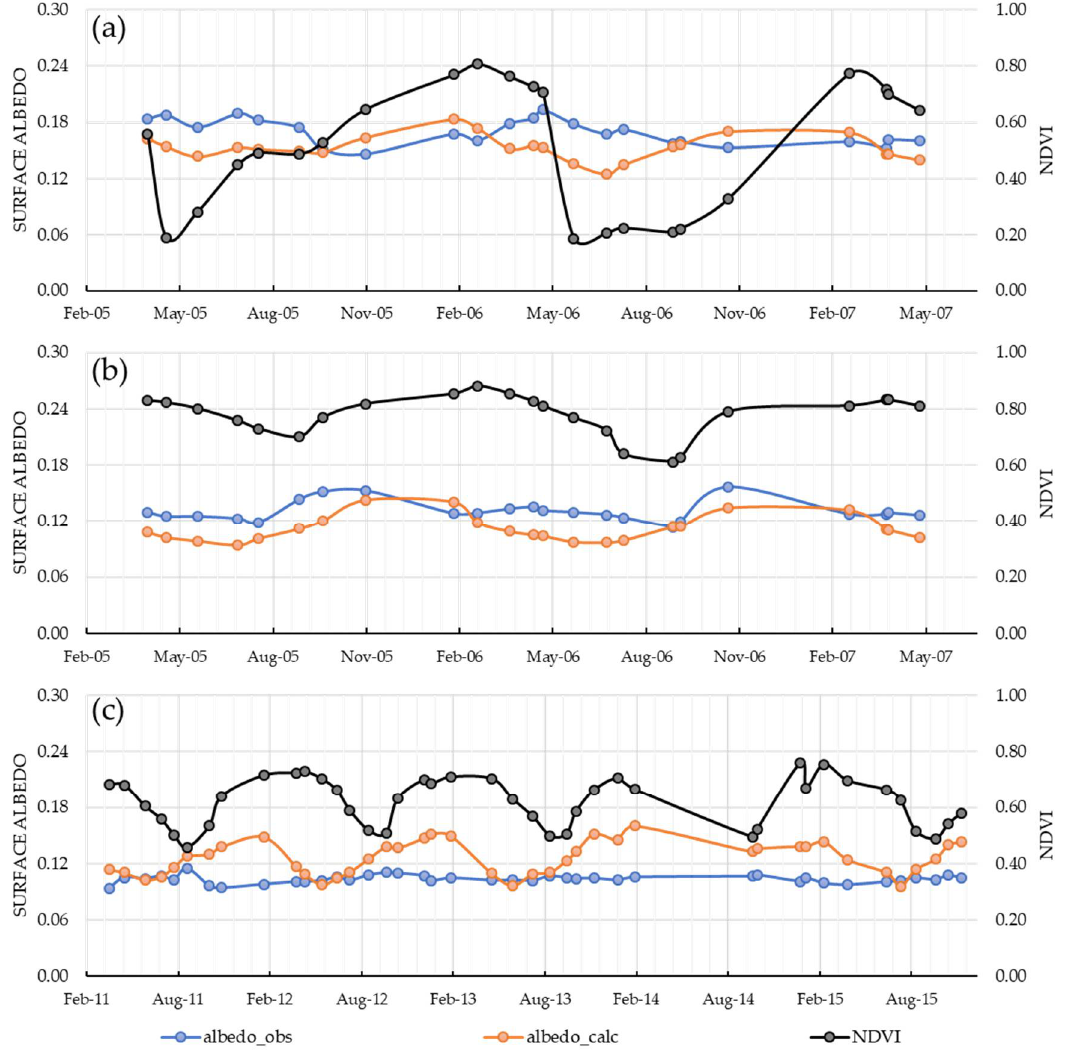
Figure 3. Observed (blue) and estimated (orange) broadband surface albedo (blue), and Normalized difference vegetation index (black) at ( a ) USR, ( b ) PDG and ( c ) RECOR experimental sites, for METRIC processing dates (Table S1).